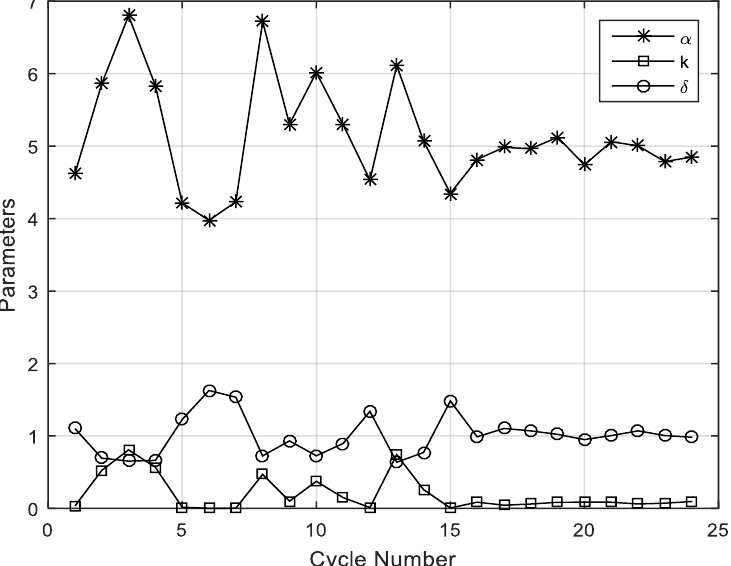
Figure 5. Variation of the ML estimate of the parameter 𝛼 , 𝑘 , and 𝛿 over different sunspot number cycles.